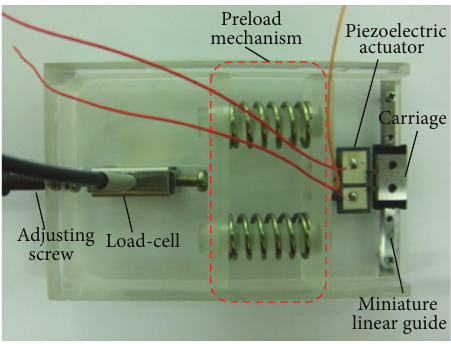
Figure 7: The linear stage using the large thrust piezoelectric actuator.